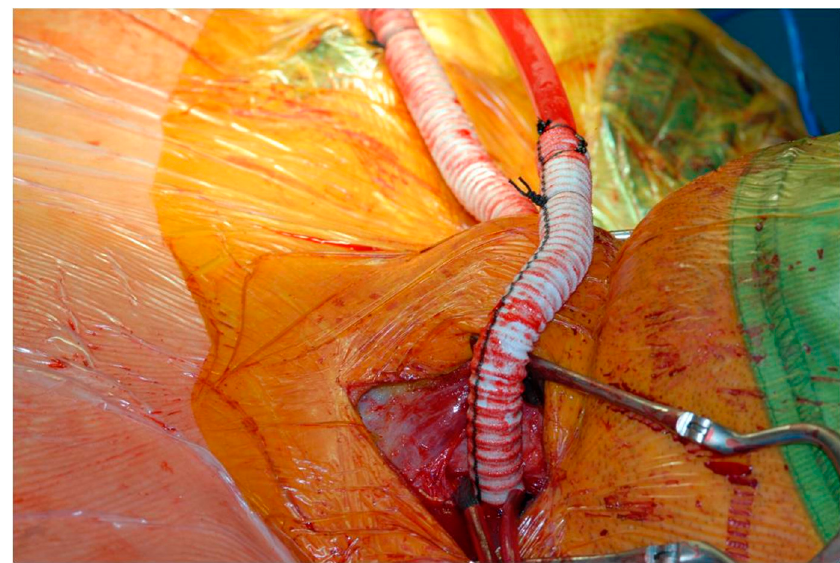
Figure 5. Completion of the end-to-side anastomosis for cerebral perfusion.